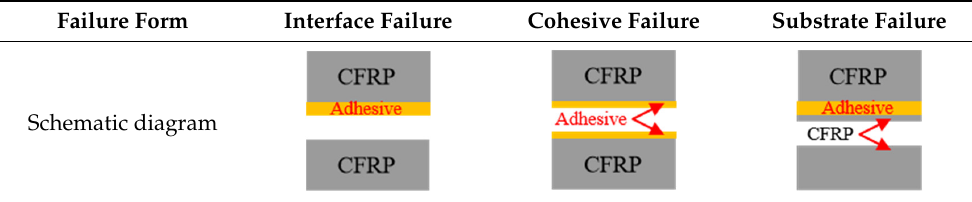
Table 8. Fracture morphology and failure forms of CF/EP single-lap joints with different surface treatment methods. The blue mark indicates epoxy resin glue and the white mark indicates the ex- posed carbon fiber substrate. Surface Treatment Method